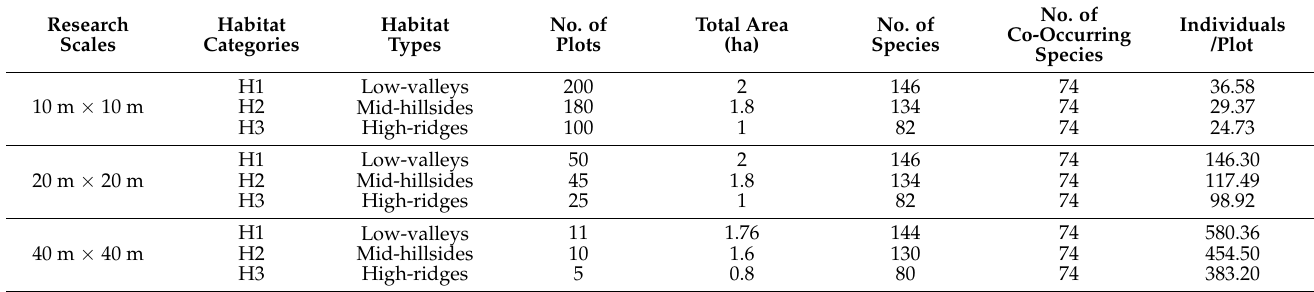
Table 1. Basic information about the habitat categories of the 5-ha forest plots at different scales.